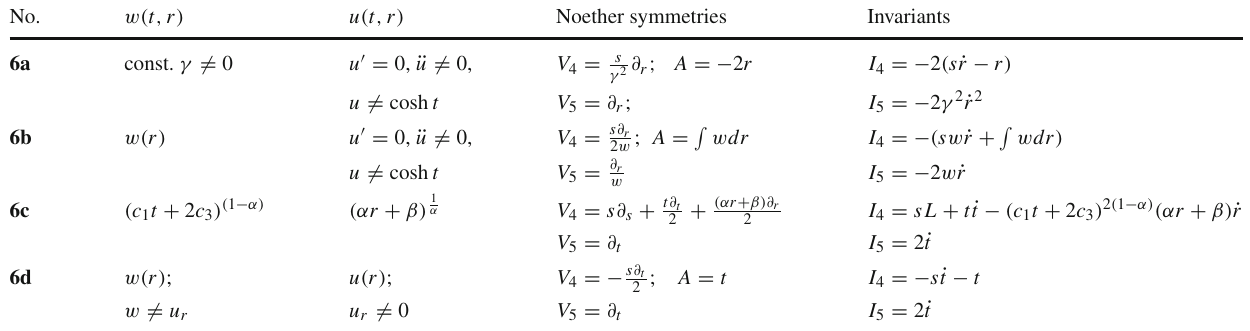
Table 3 Metrics admitting six Noether symmetries No. Noether symmetries